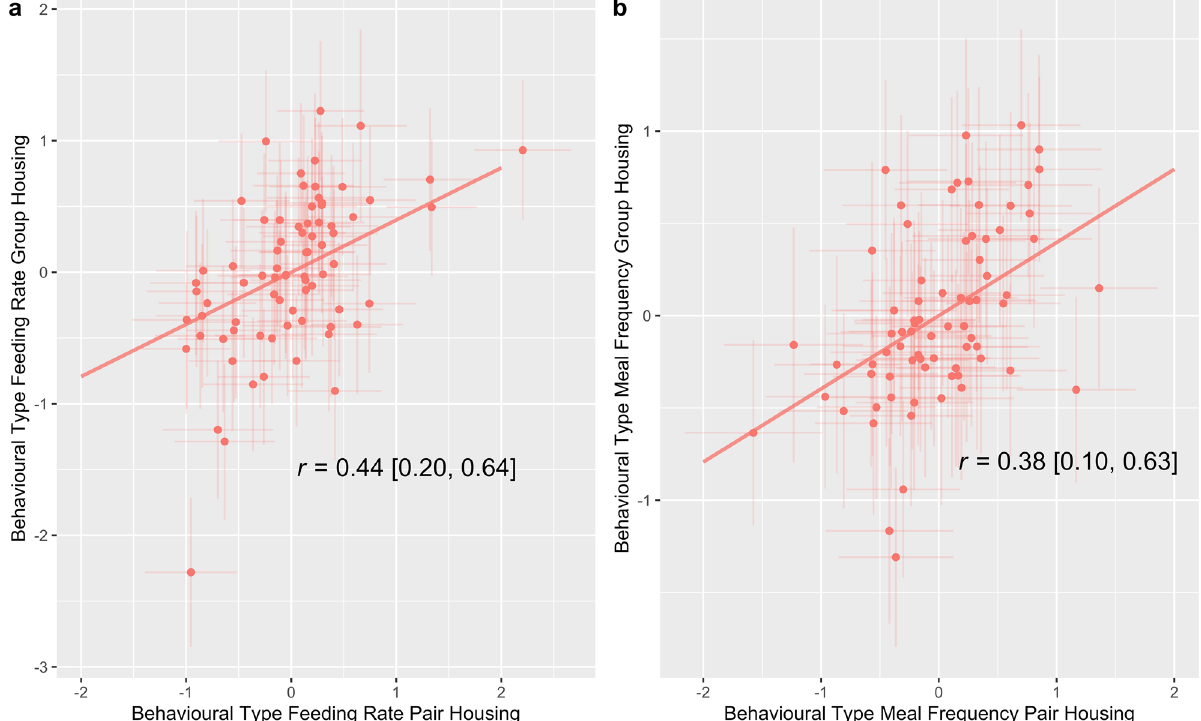
Figure 1. Visual representation of the line of best fit of the individual correlation (r) for feeding rate and meal frequency behavioural types between contexts. The credibility intervals are shown in square brackets. Panel ( a ) reports the correlation for feeding rate behavioural types between contexts. Panel ( b ) reports the correlation for meal frequency behavioural types between contexts. Posterior means and 95% credible intervals of point estimates for behavioural types are shown. The values on the x and y axes represent estimates for behavioural types which were calculated from the scaled response variables in the